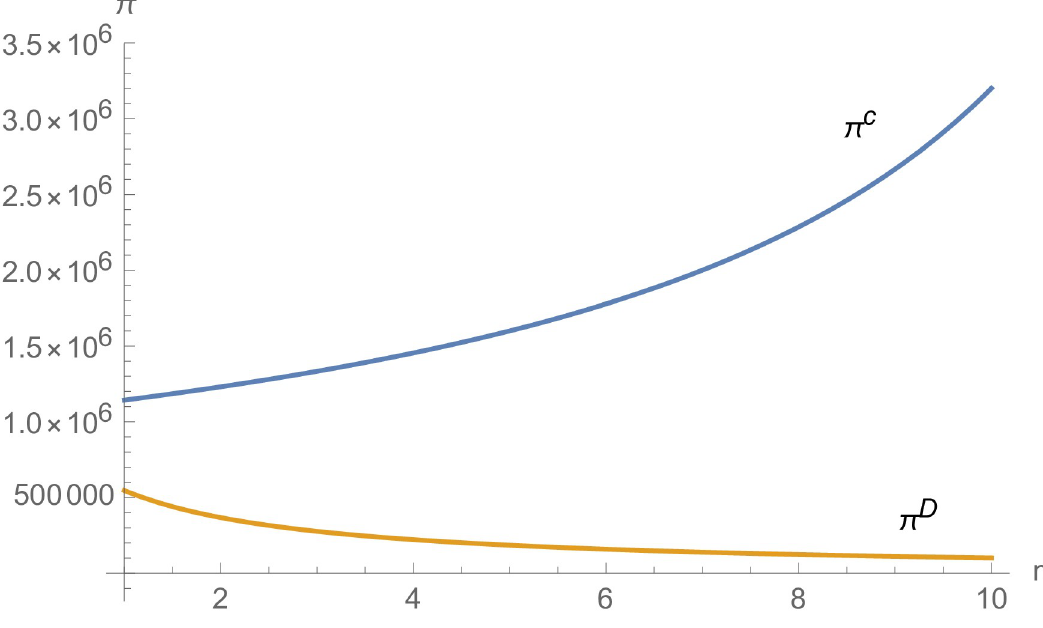
Fig 35. The impact of n on π .